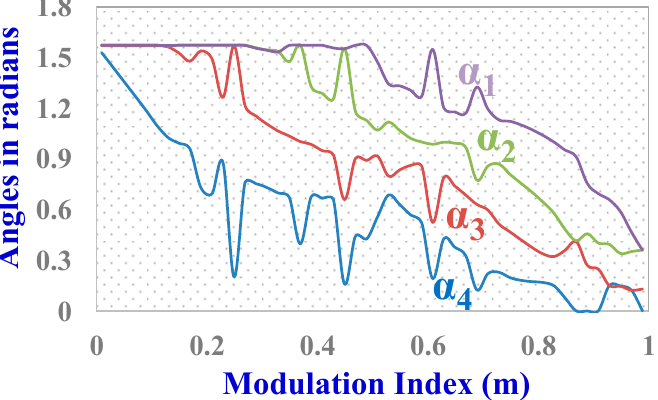
Figure 5. Switching angles vs. modulation index (varied from 0.01 to 1) for a nine-level output voltage.